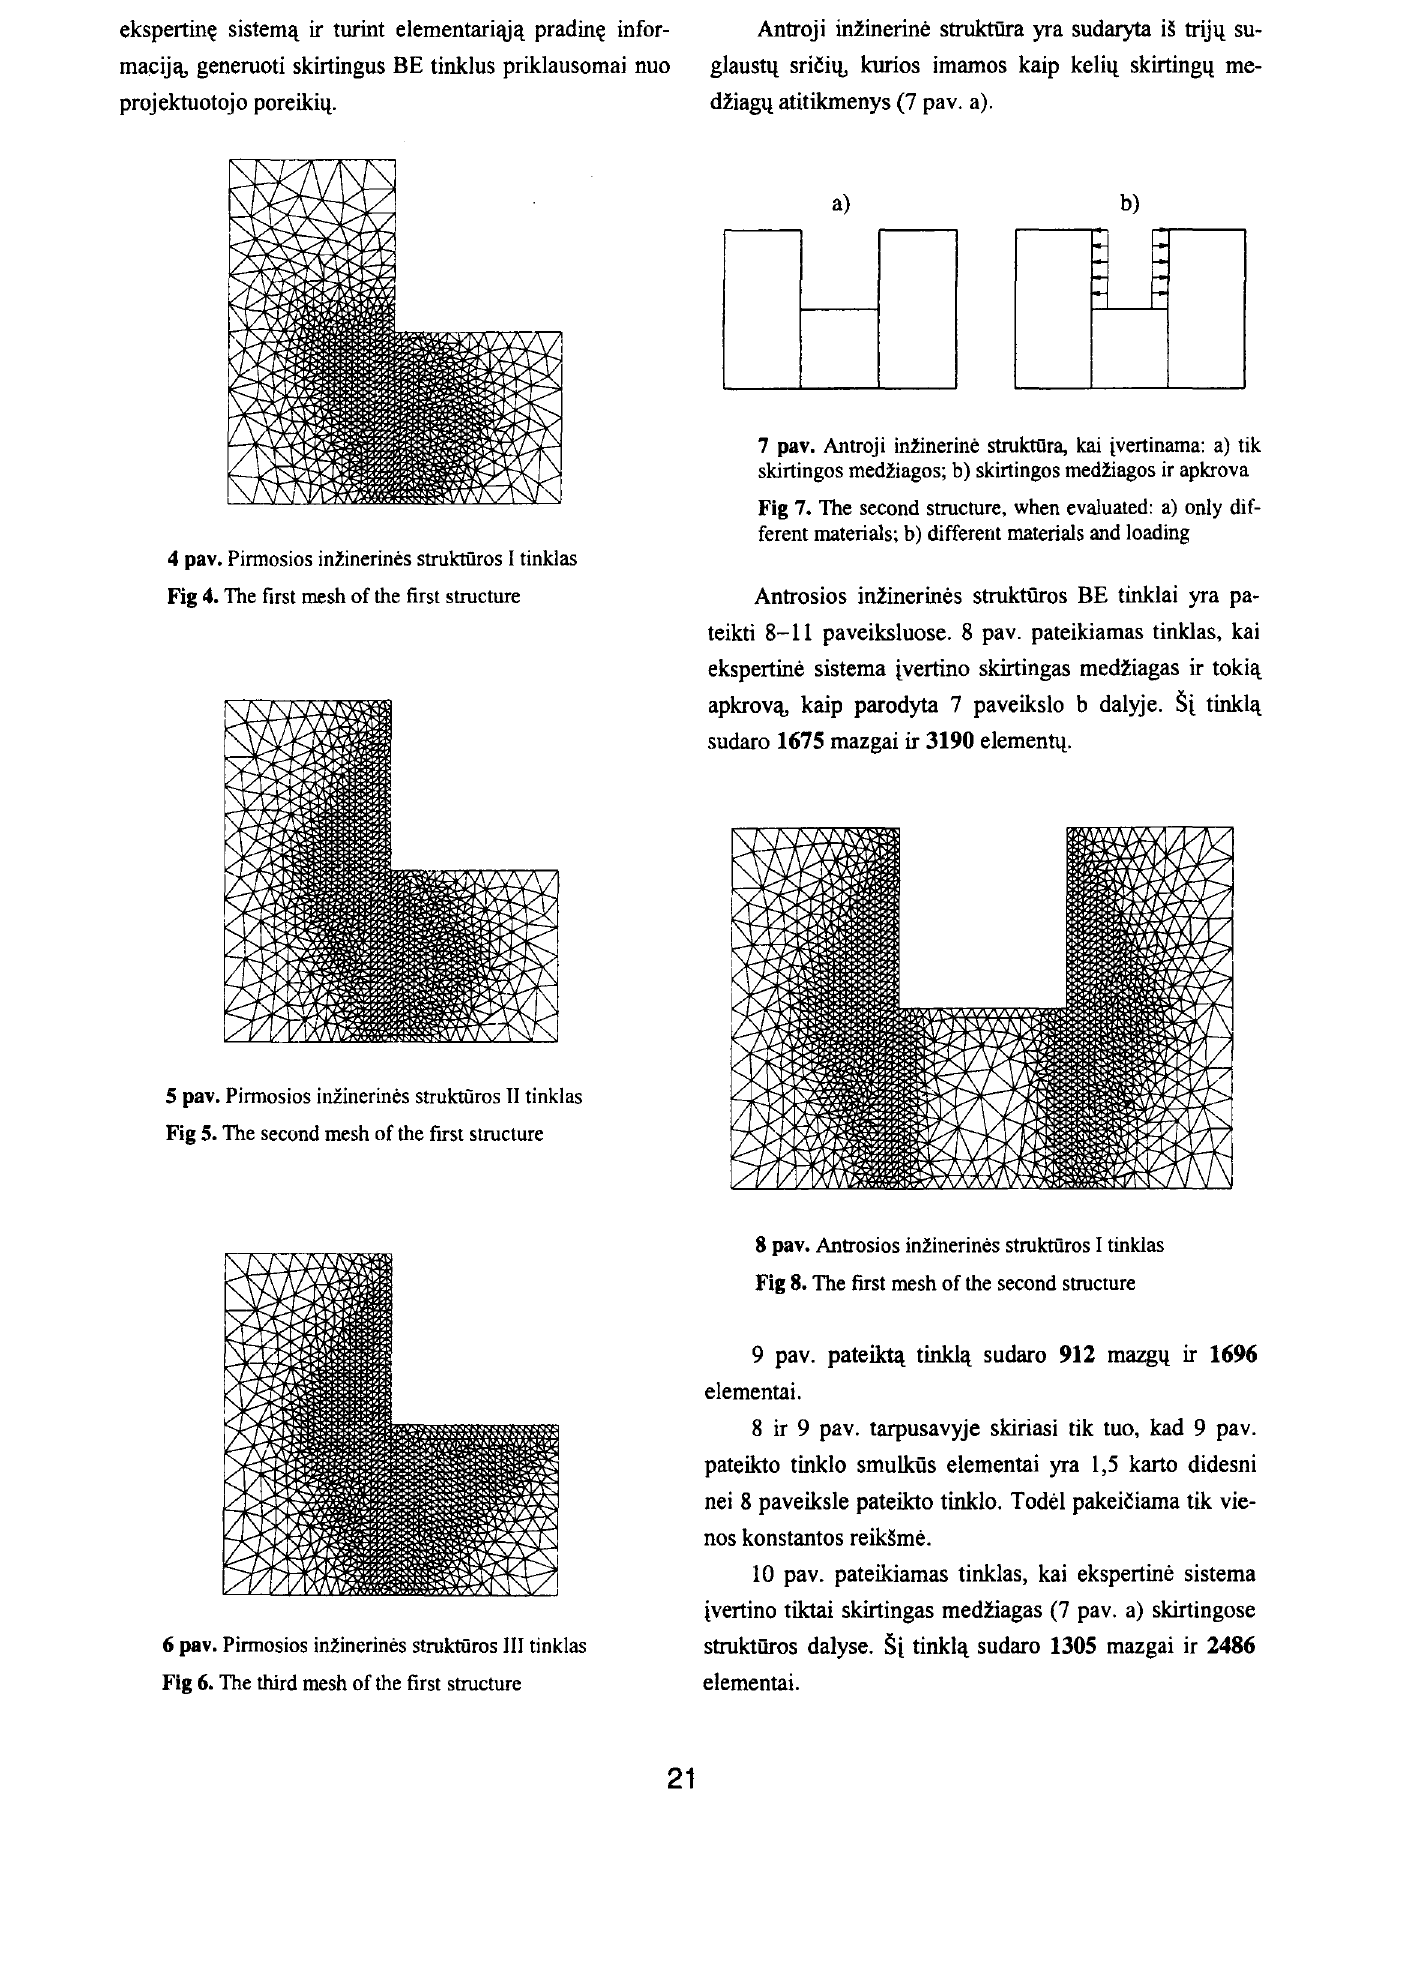
nei 8 paveiksle pateikto tinklo. Todel pakeiciama tik vie nos konstantos